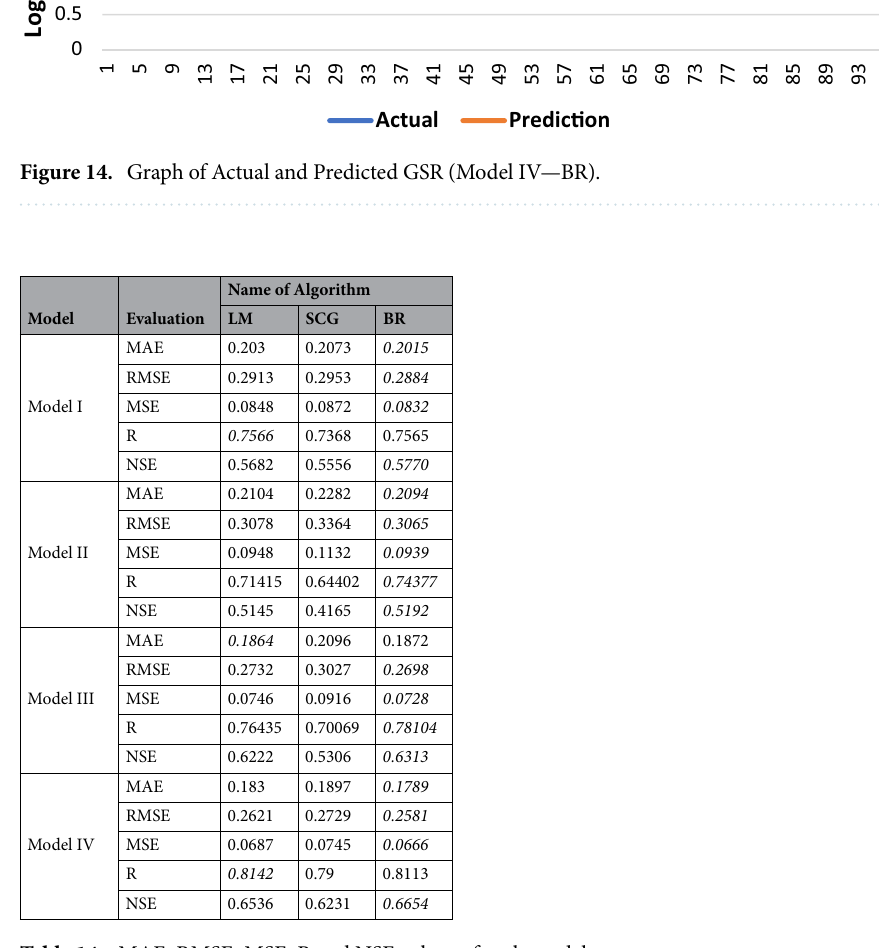
Table 14. MAE, RMSE, MSE, R and NSE values of each